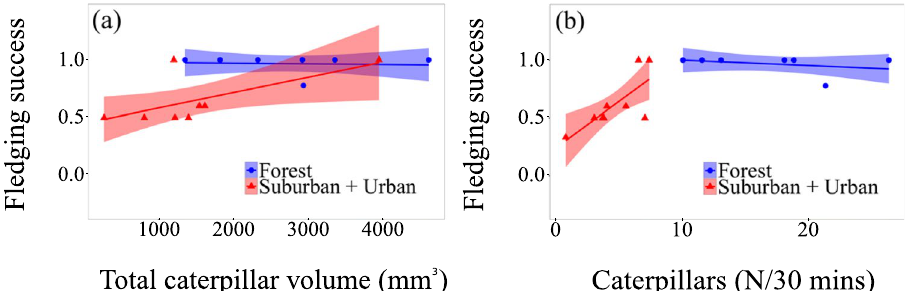
Figure 4. Fledging success of blue tits predicted from caterpillar provisioning. ( a ) Relationship of total volume of caterpillars fed to a brood (x-axis) and fledging success (number of fledglings divided by number of hatchlings, y-axis). Data for the urban and suburban site were pooled in a single “suburban + urban” variable because of low sample size due to high nestling mortality at these two sites. ( b ) Relationship between number of caterpillars fed to a brood over 30 min and its fledging success. In this case a significant interaction site * caterpillars was found, indicating a positive relationship only for the suburban + urban broods, whereas the fledging success of the forest broods was weakly affected by the number of caterpillars fed. Blue colour and dots represent forest, red colour and triangles represent suburban + urban birds. Each symbol represents a single nest. Lines represent estimates from linear regression models, and shaded areas